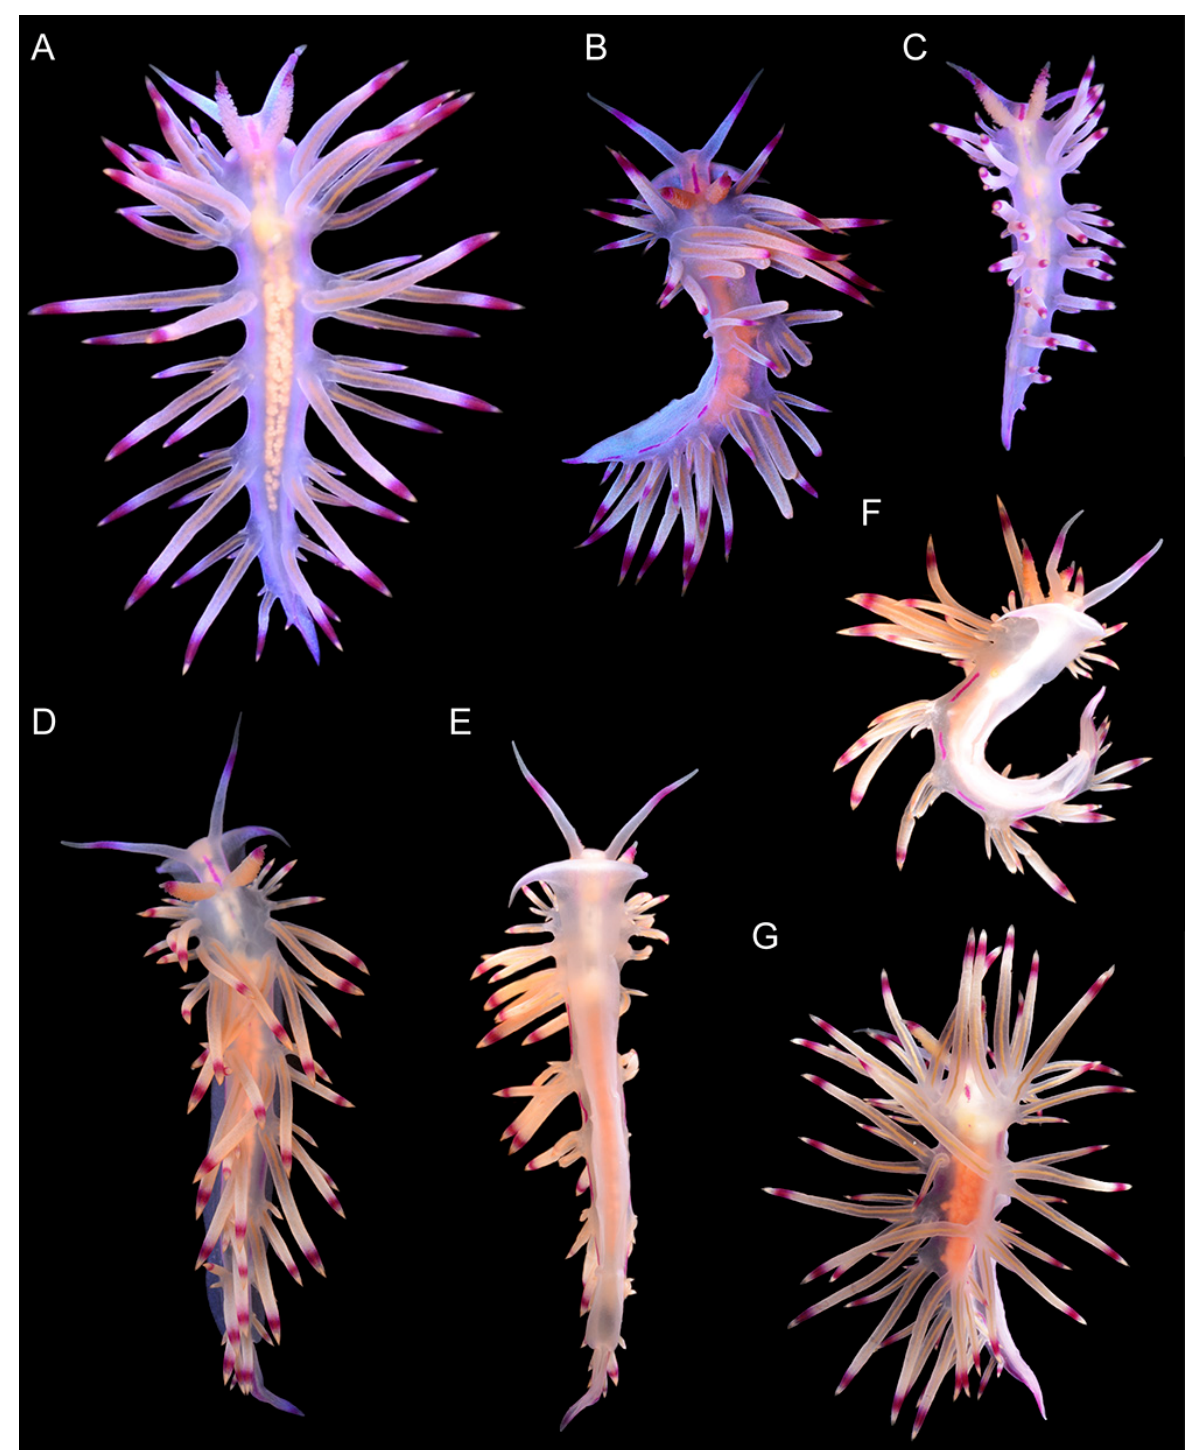
Figure 3. Coryphellina lotos , external morphology and variability of coloration. ( A )—IZ-T9, specimen 19 mm in length (preserved). ( B )—IZ-T31, specimen 17 mm in length (preserved). ( C )—IZ-N1, spe-cimen 12 mm in length (preserved). ( D )—IZ-N42, specimen 17 mm in length (preserved), dorsal view. ( E )—IZ-N42, ventral view. ( F )—IZ-N42, lateral view. ( G )—IZ-L4, specimen 23 mm in length (preserved). Photo credits: ( A , G ): Elena Mekhova; ( B ): Tatiana Antokhina; ( C – F ): Yury Deart. Color (Figures 3 and 4) : Background from translucent white to violet and purple. Digestive gland mass and diverticula in cerata from peachy to light brown. Cerata